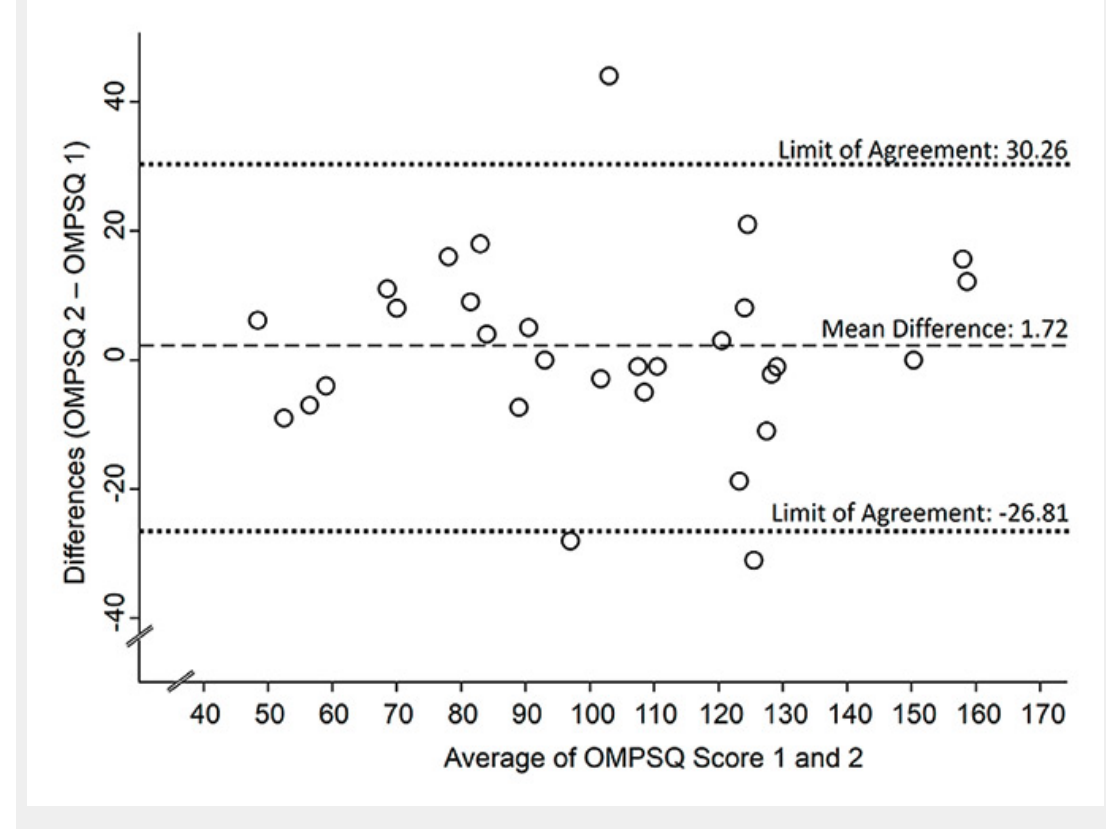
Figure 2 Bland–Altman plot for the Örebro Musculoskeletal Pain Screening Questionnaire (OMPSQ) total score, with limits of agreements interval (pointed line) of the mean difference (dashed line) between the two assessment